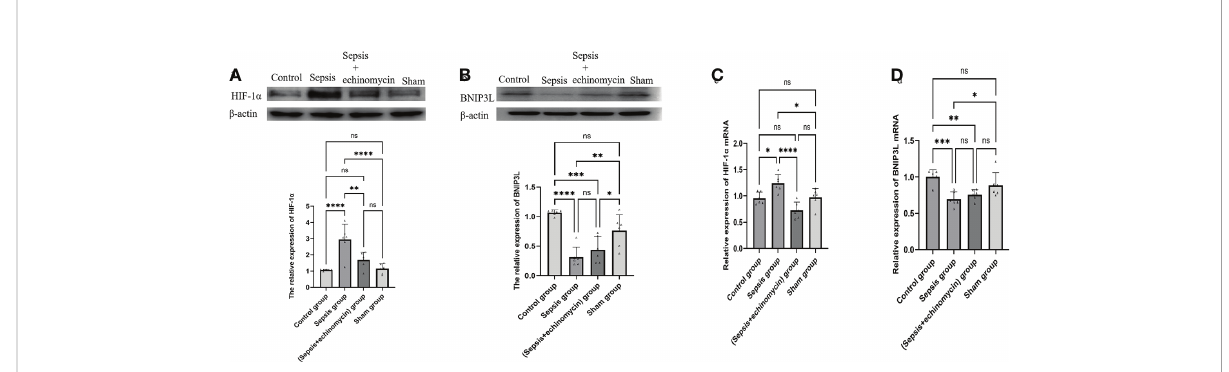
FIGURE 5 The HIF-1a and BNIP3L protein and m RNA expression in hippocampus tissue. (A) : HIF-1 a protein expression in hippocampus; (B) : BNIP3L protein expression in hippocampus; (C) : HIF-1 a mRNA expression in hippocampus; (D) : BNIP3L mRNA expression in hippocampusCompared with other three groups, sepsis up-regulated the HIF-1a and down-regulated BNIP3L protein and m RNA expression in the hippocampus tissue of mice.*: p < 0.05, **: p < 0.01, ***: p < 0.001,****: p < 0.0001, ns: p > 0.05.